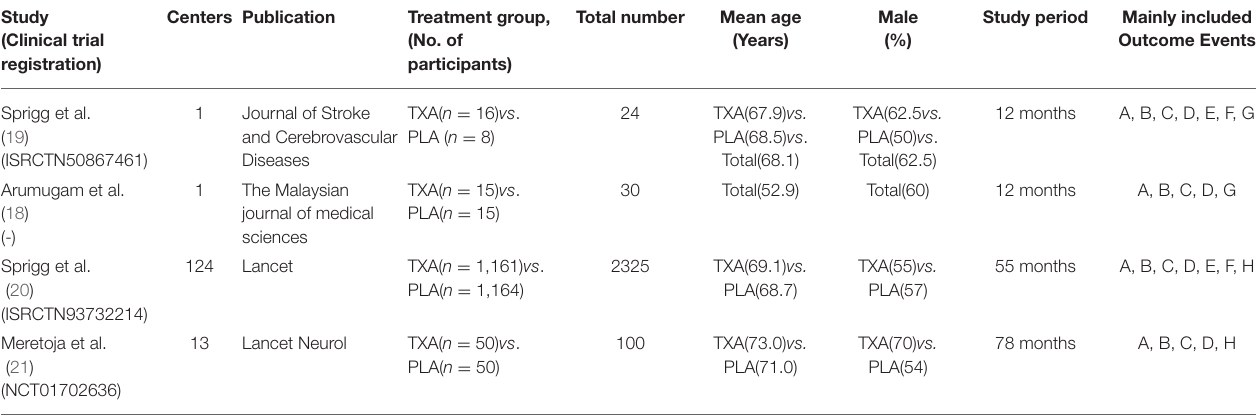
TABLE 1 | Characteristics of the included studies and outcome